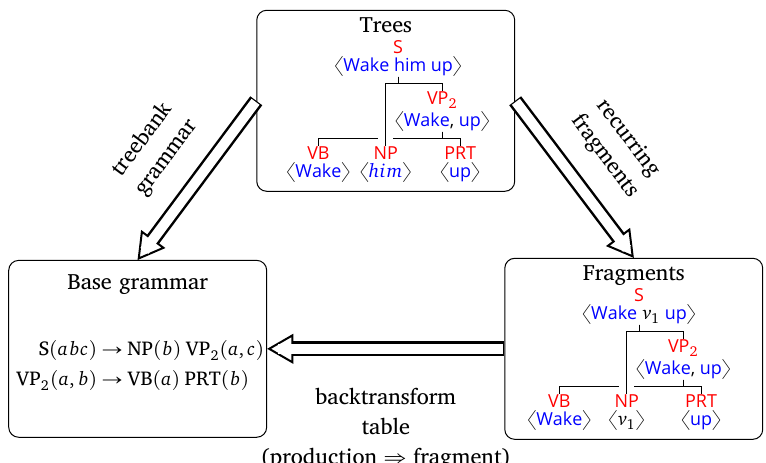
Figure 12: Diagram of the methods of grammar